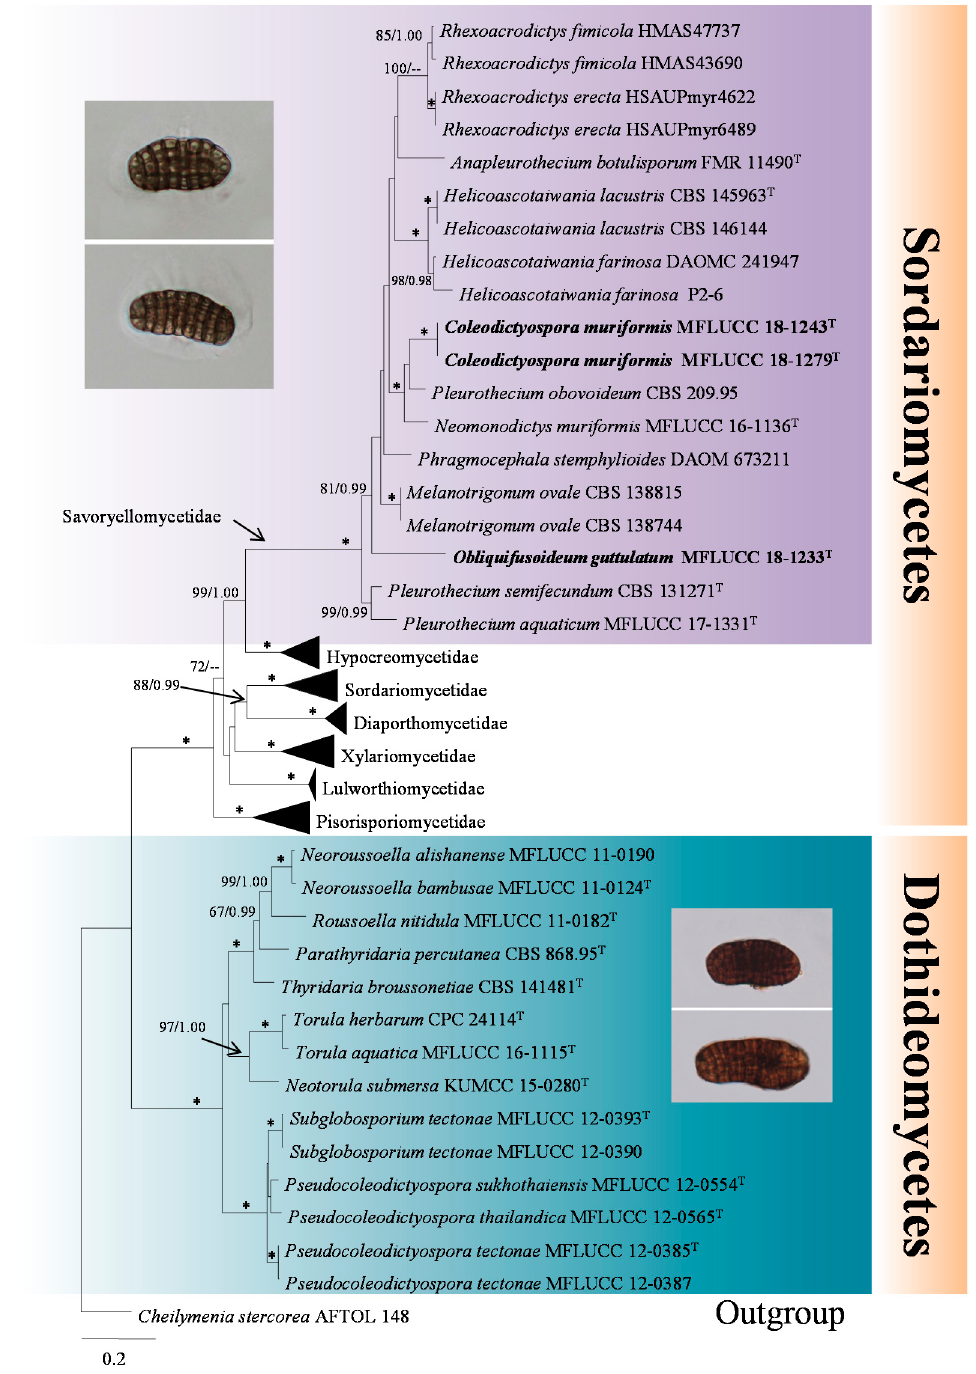
Figure 2 . RAxML tree with taxa from two classes, Dothideomycetes and Sordariomycetes, to show the phylogenetic relationships between Coleodictyospora and Pseudocoleodictyospora . The illustrations of species in Coleodictyospora and Pseudocoleodictyospora are displayed near the generic names. The multi-locus tree is generated from combined LSU, SSU, ITS and rpb2 sequence data. Bootstrap support values for maximum likelihood (the first value) equal to or greater than 60% and Bayesian posterior probabilities (the second value) equal to or greater than 0.95 are placed near the branches as ML BS/BI PP. The asterisk “*” represents bootstrap support values with 100% ML BS and 1.00 BI PP. The tree is rooted to Cheilymenia stercorea AFTOL 148. The ex-type cultures are indicated using “ T ” after strain numbers and the new species introduced in this study are indicated in bold .